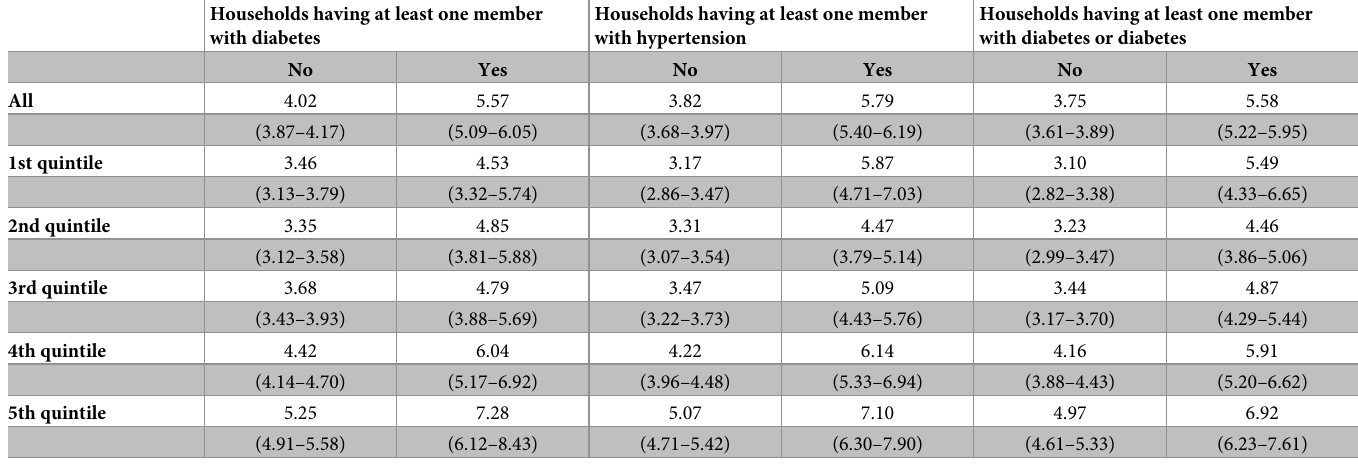
Table 2. Average (95% confidence interval) percentage of total household health among Mexican households according to presence of a member with diagnosed diabetes or hypertension. Households having at least one member with